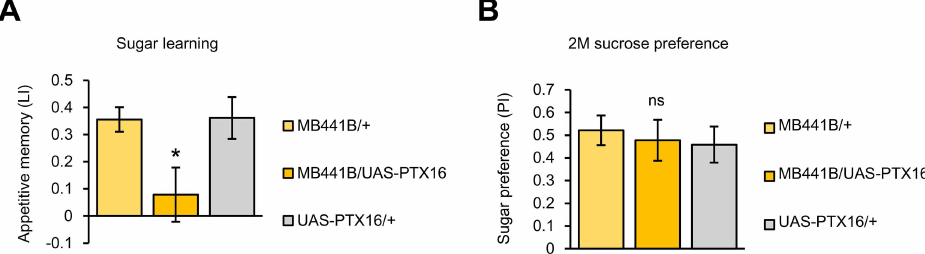
Fig 10. Requirement of G α o signaling in PAM- γ 3for appetitive learning. (A) Pertussis toxin expression in the PAM- γ 3impairs immediate sugar memory. n = 8. (B) Innate sugar preference is not significantly impaired. n = 8. ns, not significant, * p <